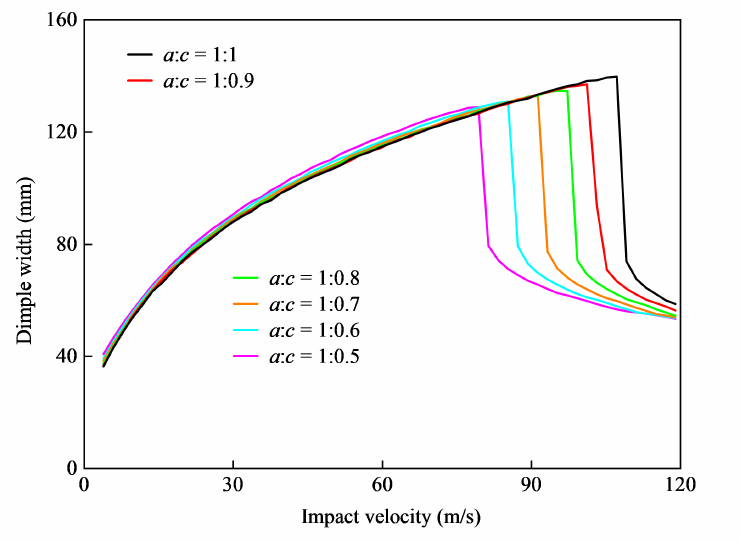
Figure 16. Dimple width changes with a decrease in shell depth with a constant length of the a